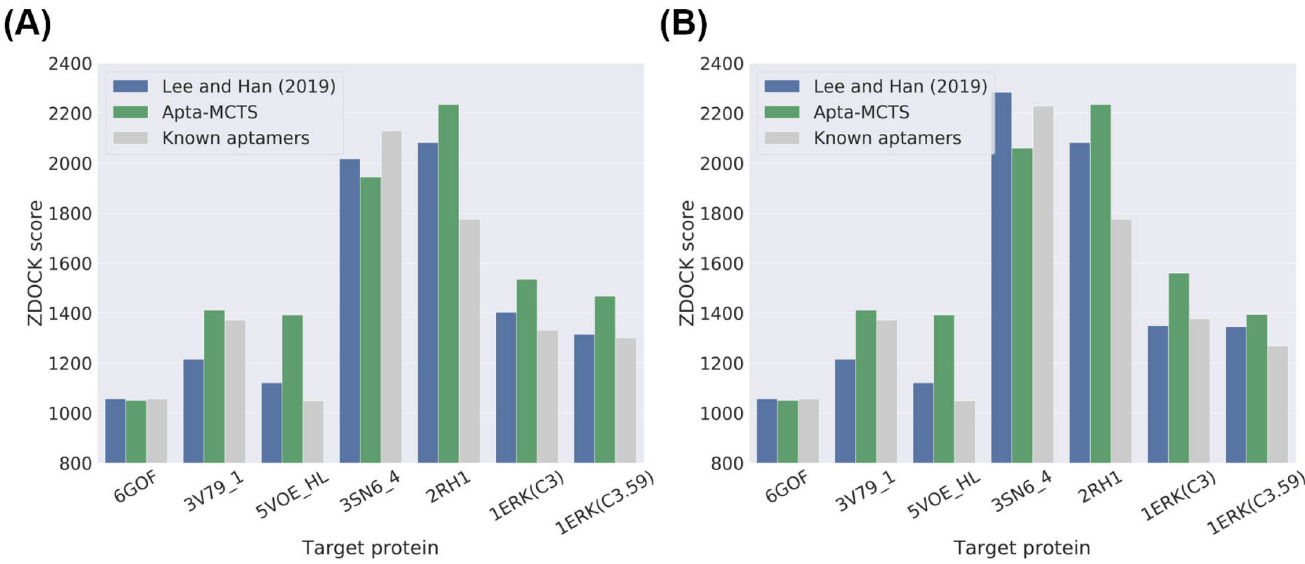
Fig 3. Evaluation of aptamer sequence generation in terms of binding affinity with six target proteins using ZDOCK docking simulation. (A) ZDOCK scores of aptamers using protein structures from the PDB and (B) ZDOCK scores using structures built via the Swiss-Model server. For protein 1ERK, there are two known aptamers, C3 and C3.59, with 90 and 59 bases, respectively. We compared the docking scores of aptamer sequences generated by our model (in green bar) and Lee et al . [21] (in blue); the known aptamers (in gray) are listed in Table 2. The candidates of our Apta-MCTS (in green bar) yielded higher docking scores than the results reported by Lee et al . [21] (in blue) and the known aptamers (in gray) for five cases: 3V79_1, 5VOE (chain H and L), 2RH1, 1ERK(C3) and 1ERK(C3.59). Additional details are available in S2 Table for (A) and S3 Table for